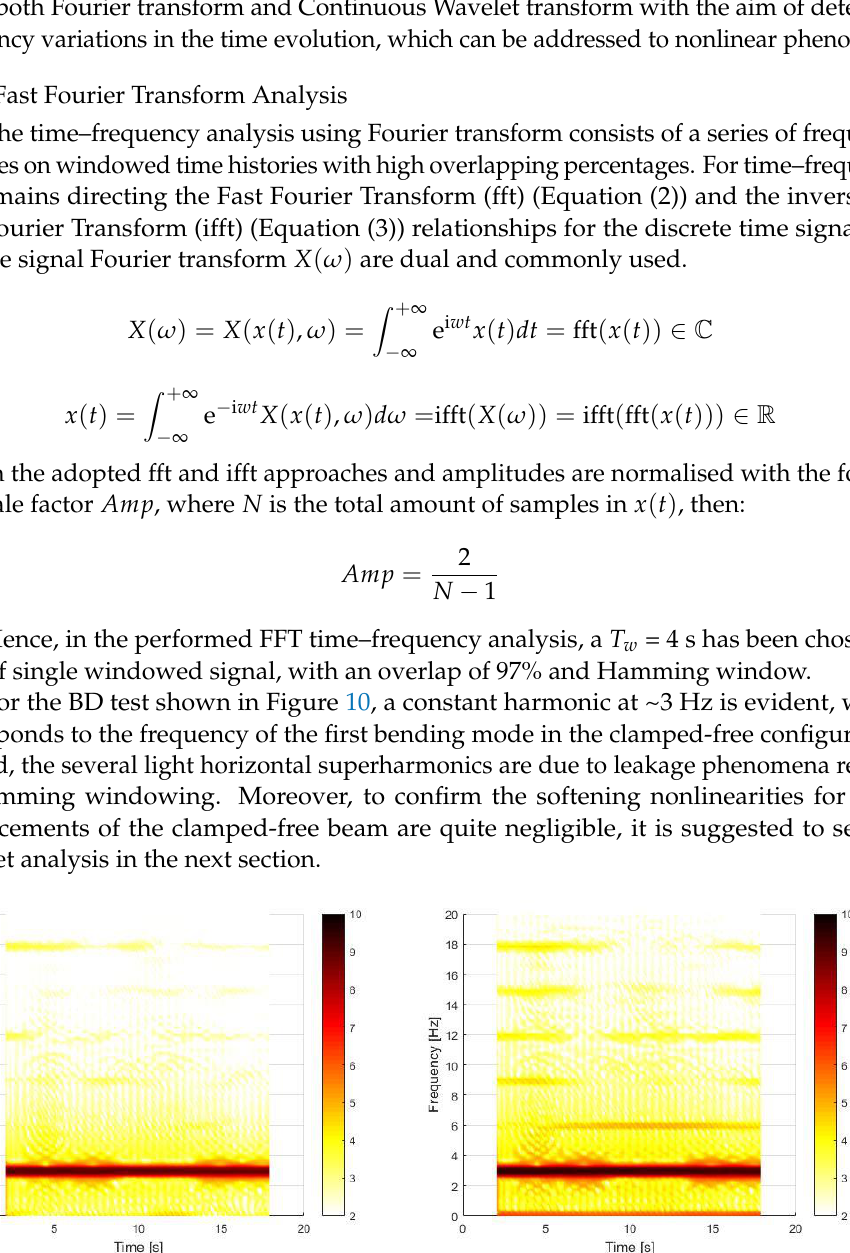
( b ) Figure 11. Time – frequency contents of MaD test for P11 (magnet) ( a ) and P14 (mass) ( b ) profilome- ter points. Results of the time – frequency analysis for the CD test are shown in Figure 12. By analysing the mass point P14, reported in Figure 12b, it is evident the 1st frequency tran- sitions with a decrement in time. The 1st natural frequency decreases from a value of ~5 Hz to ~3 Hz when the contact is no longer present. Moreover, the superharmonics of the